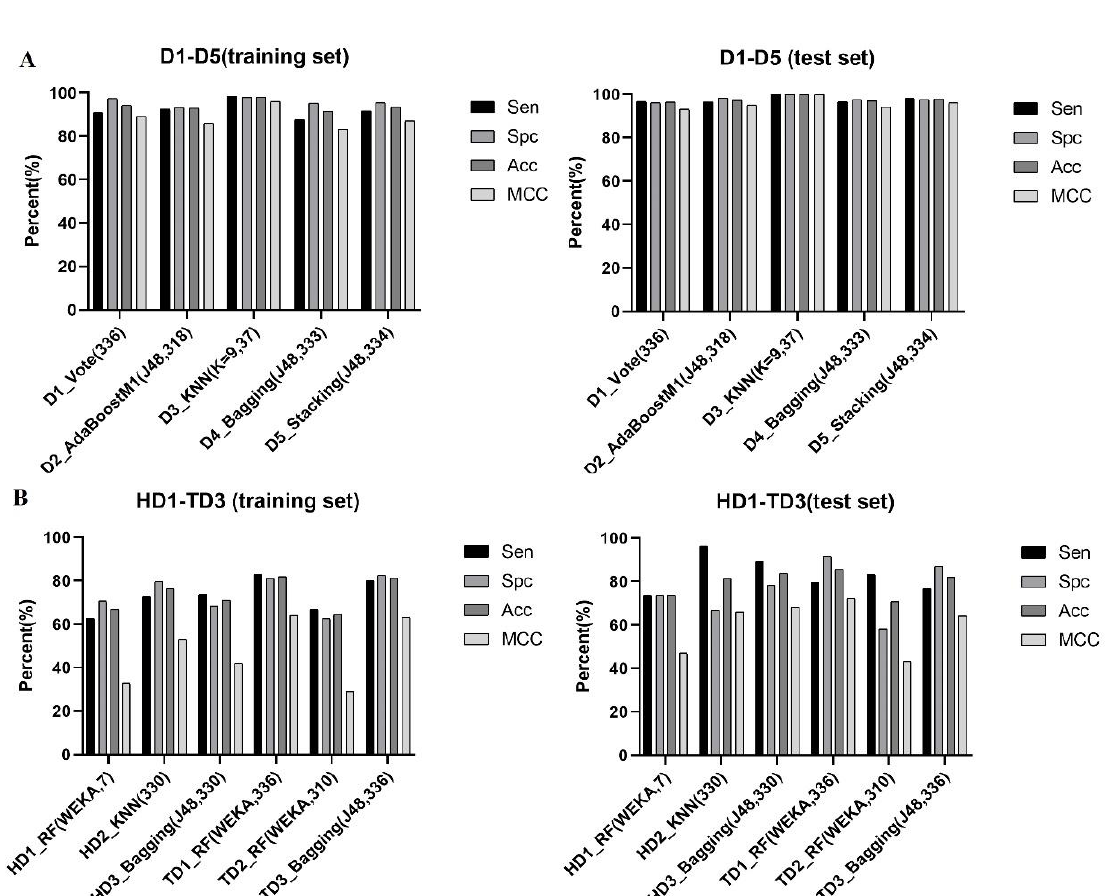
Figure 4. The optimal model for each dataset. ( A ) The performance of the optimal models of 5 ACPs datasets on the training set and the test set. ( B ) Performance of optimal models of hemolytic peptide and toxic peptide datasets on training sets and test sets.